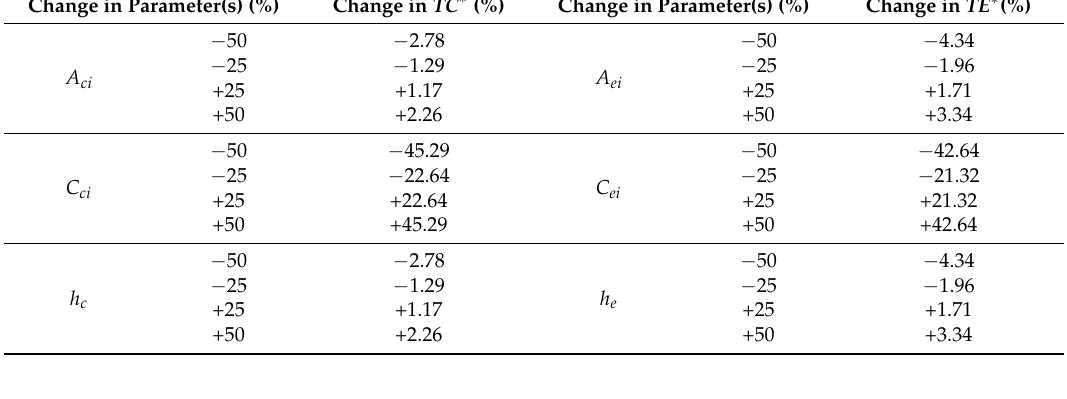
Table 7. Sensitivity analysis for important parameters of numerical experiment.